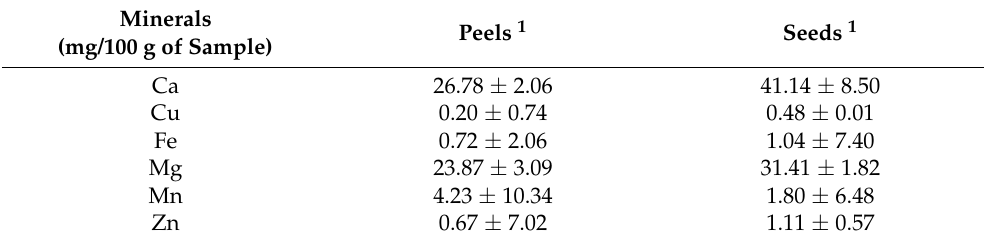
Table 1. Mineral content in avocado fresh peels and